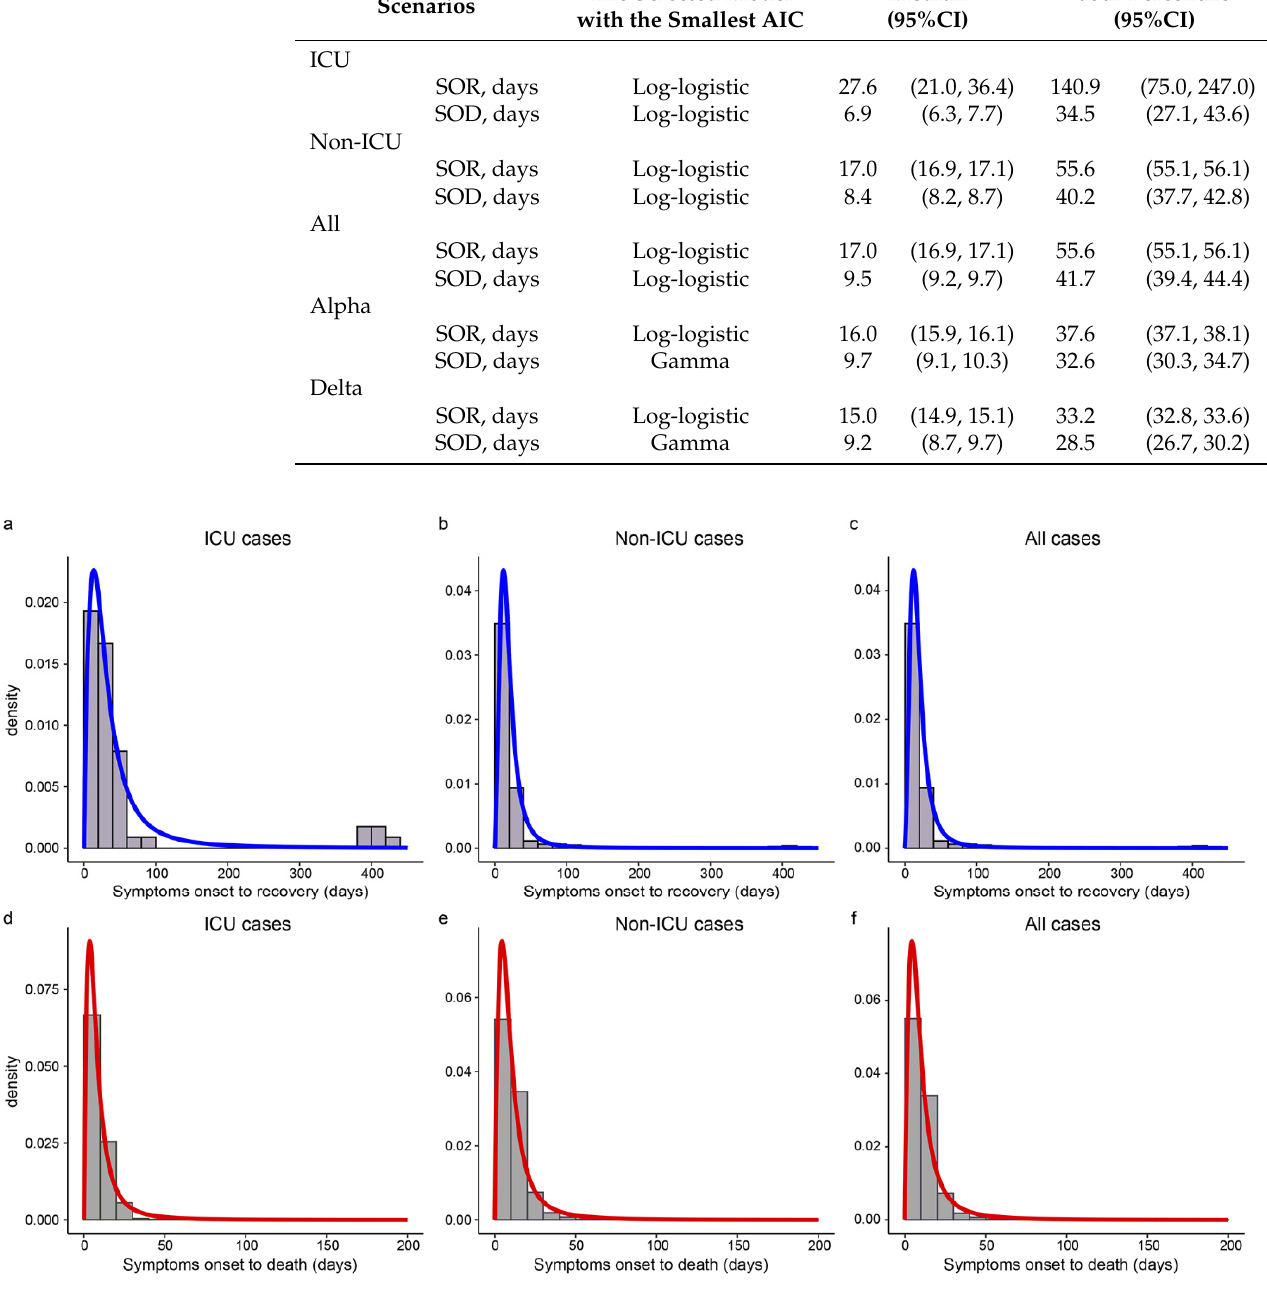
Figure 4. The estimated distributions of SOR and SOD in different subgroups. Panels ( a – c ) show the histograms and the estimated density curves of SOR in ICU, non-ICU, and all cases, respectively. Panels ( d – f ) display the histograms and the estimated distributions of SOD in ICU, non-ICU, and all cases, respectively.